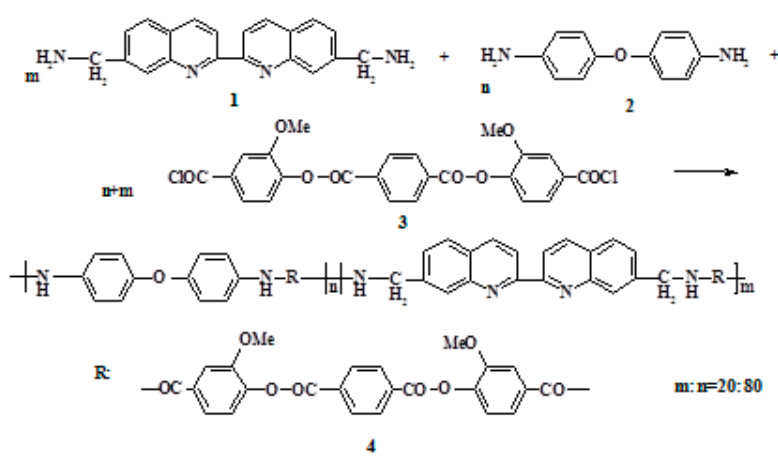
Figure 1. Scheme of PEA synthesis.